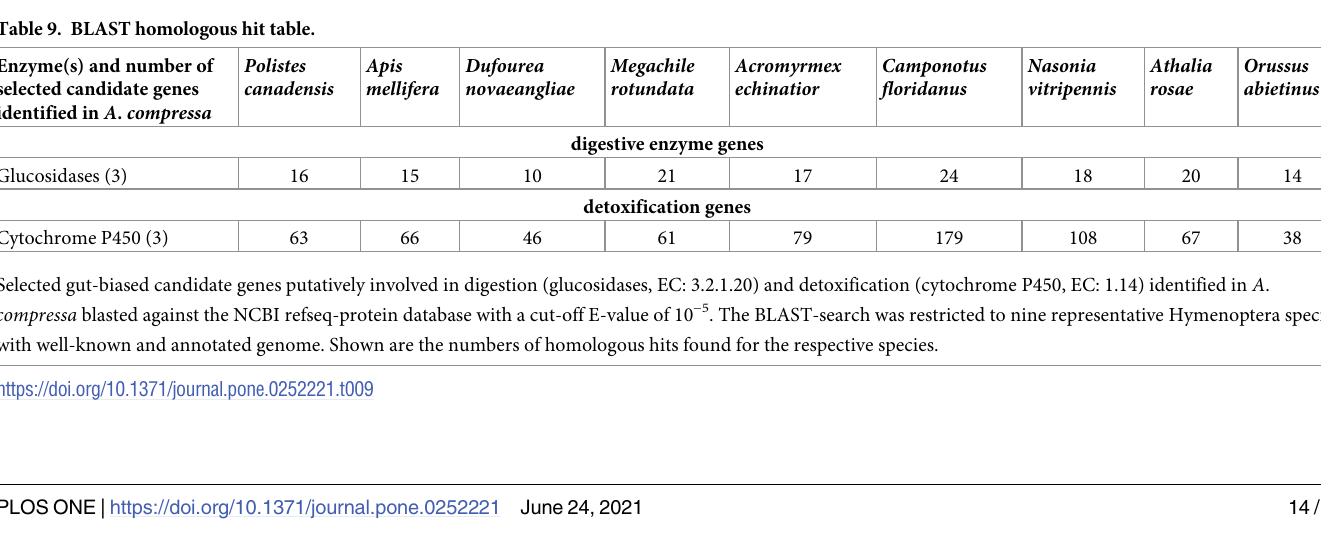
Fig 4. Normalized expression level of up- and down regulated genes putatively involved in digestion and detoxification processes. A) Up-regulated genes identified in the midgut transcriptome of A . compressa adult wasps and larvae (grey bars) are grouped according to their coding function as 1) proteinases, 2) carbohydrases, 3) lipases, and 4) detoxification enzymes. B) Down-regulated genes identified in the midgut transcriptome of A . compressa adult wasps and larvae (grey bars) are grouped according to their coding function as 1) proteinases, 2) carbohydrases, 3) lipases, and 4) detoxification enzymes (grey bars). Up- and down-regulated genes (x-axis) are plotted against their log2(FC) (y-axis). Genes exclusively found either in the adult wasps or larvae are highlighted in blue and red, respectively. Genes found in both life stages are highlighted in green. Circle size represents the number NRC found for the respective gene. Detailed information on candidate up- and down-regulated genes is provided in S5 and S6 Tables.